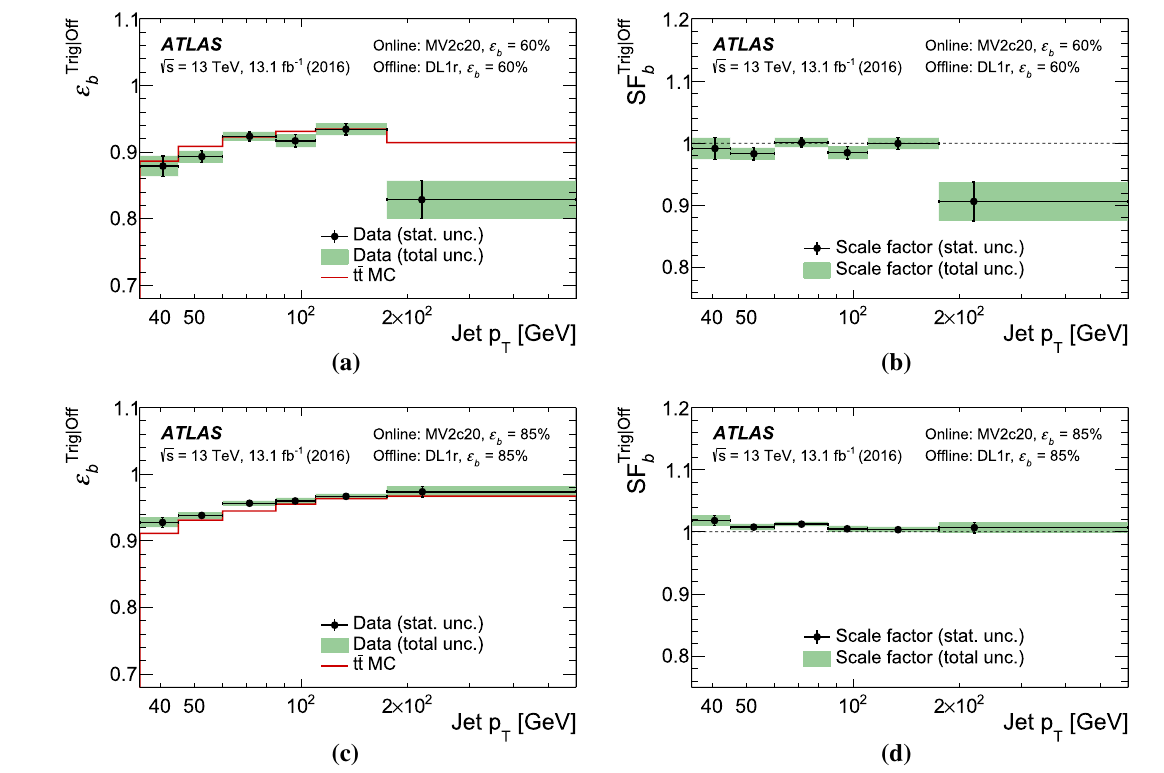
| Off Fig. 12 The conditional b -tagging efficiency, ε Trig to pass the same efficiency working points as the online jets, but using , ( a , c ) and cor- b | Off the DL1r b -tagging algorithm. Vertical error bars include data statisti- , ( b , d ) for the online MV2c20 algo- responding scale factor, SF Trig b cal uncertainties only, whereas the full band corresponds to the sum in rithmforthe60%efficiencyworkingpoint( a , b )andthe85%efficiency quadrature of all working point ( c , d ) as measured in 2016 data. Offline jets are required